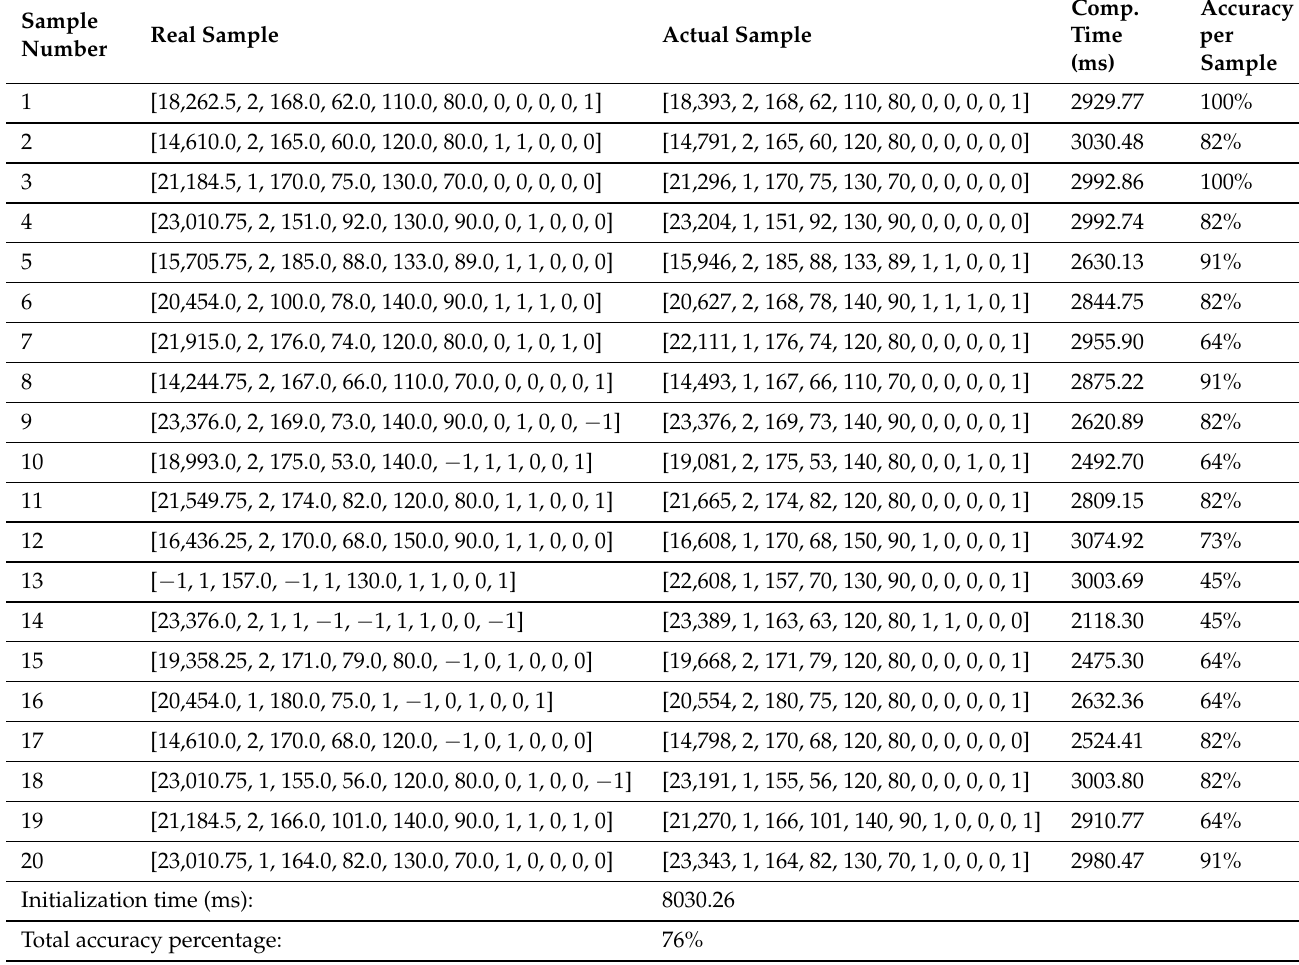
Table 9. Results of NLP-assisted data transformation from patient notes.